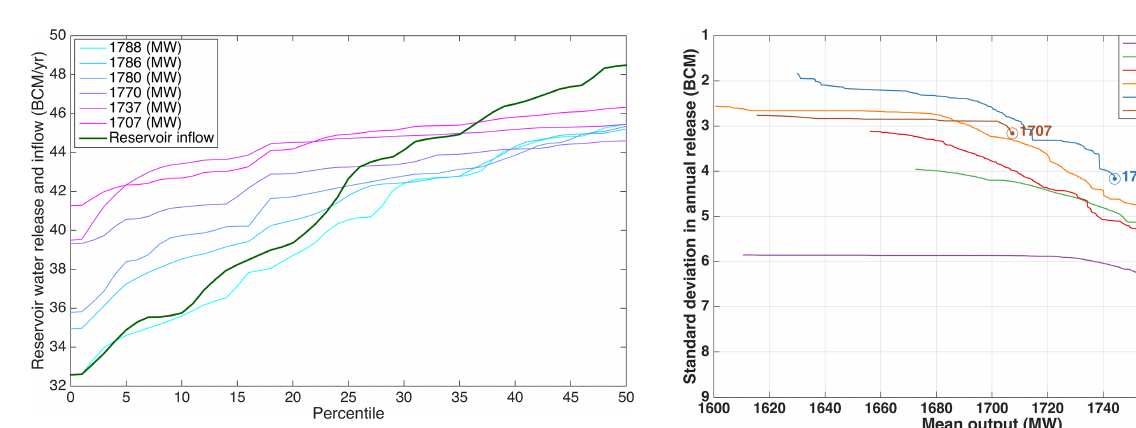
Figure 9. Multi-objective optimization of reservoir operating rules with drought mitigation